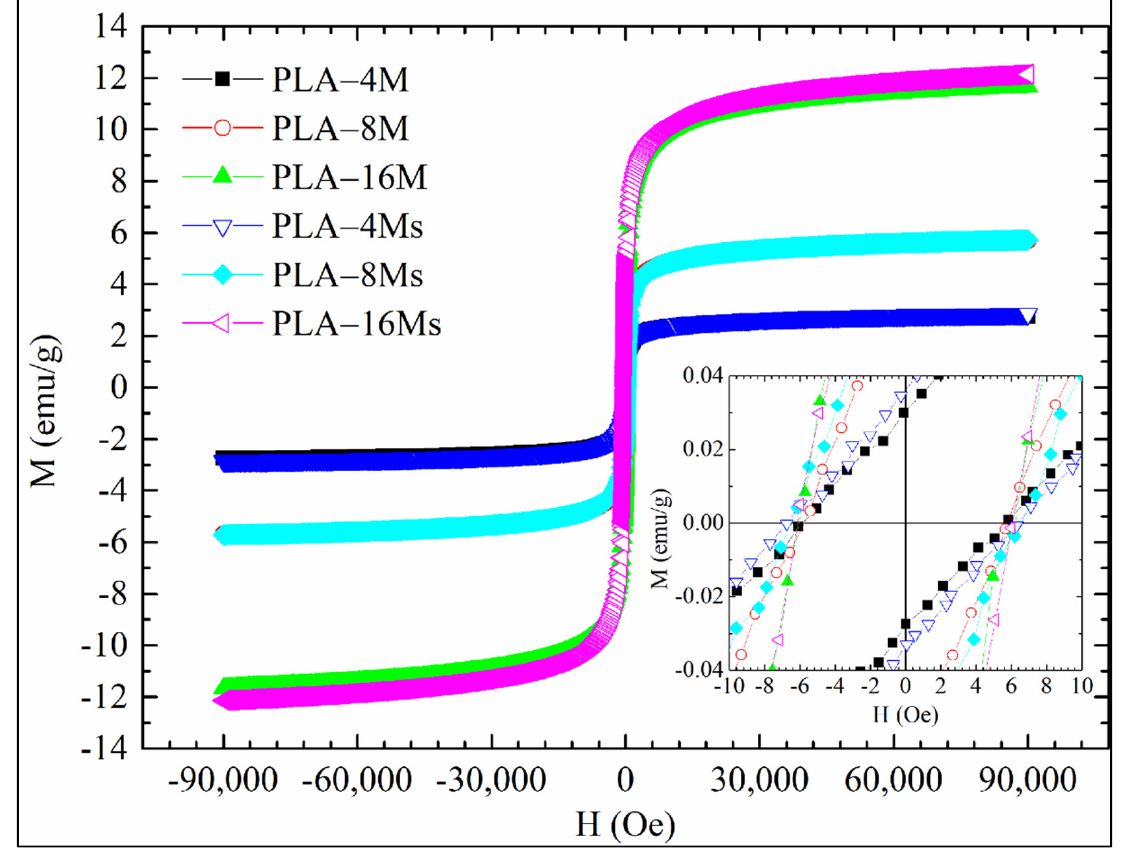
Figure 13. M(H) at a temperature of 300 K of PLA nanocomposites filled with 4–16% untreated and surface treated magnetite nanoparticles.